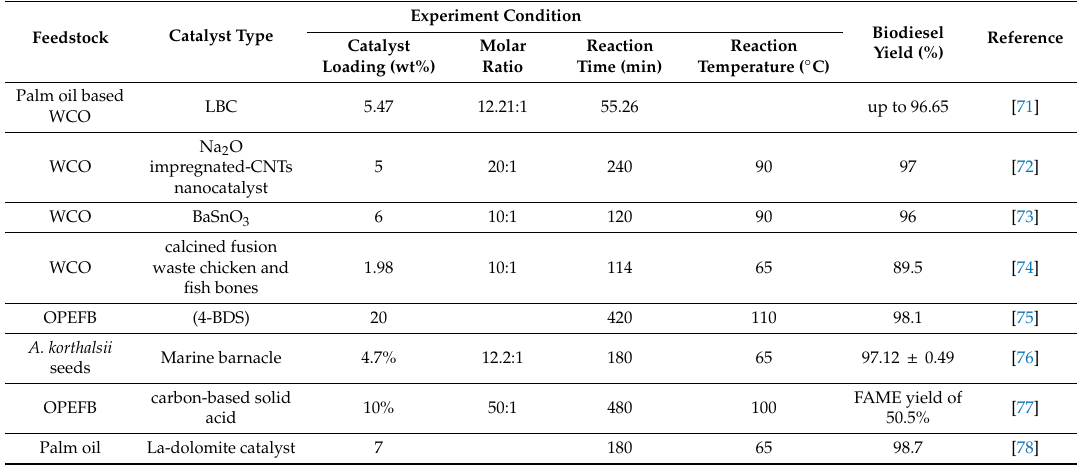
Table 3. Recent studies on biodiesel production from di ff erent sources in